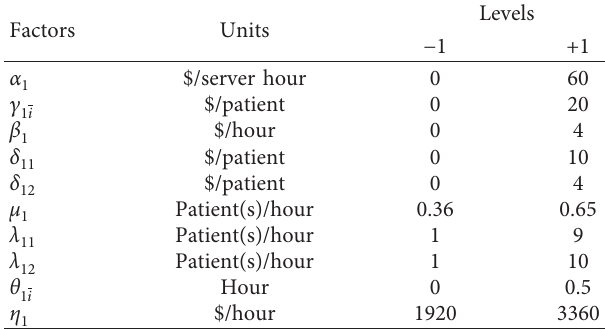
Table 1: Sets of utilization values and number of servers considered for each ED.